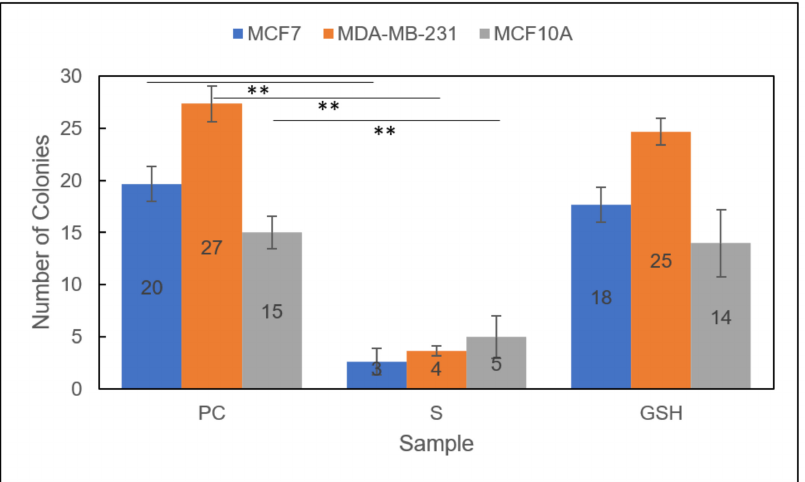
Figure 6. Colony formation capacity of MCF7 (blue), MDA-MB-231 (orange), and MCF10A (gray) cells. Sample groups include: PC (untreated), S (Group 1), and GSH (functional control) cells. Data points represent the mean ± standard deviation. Statistical differences from the positive control are shown by ** p < 0.01.